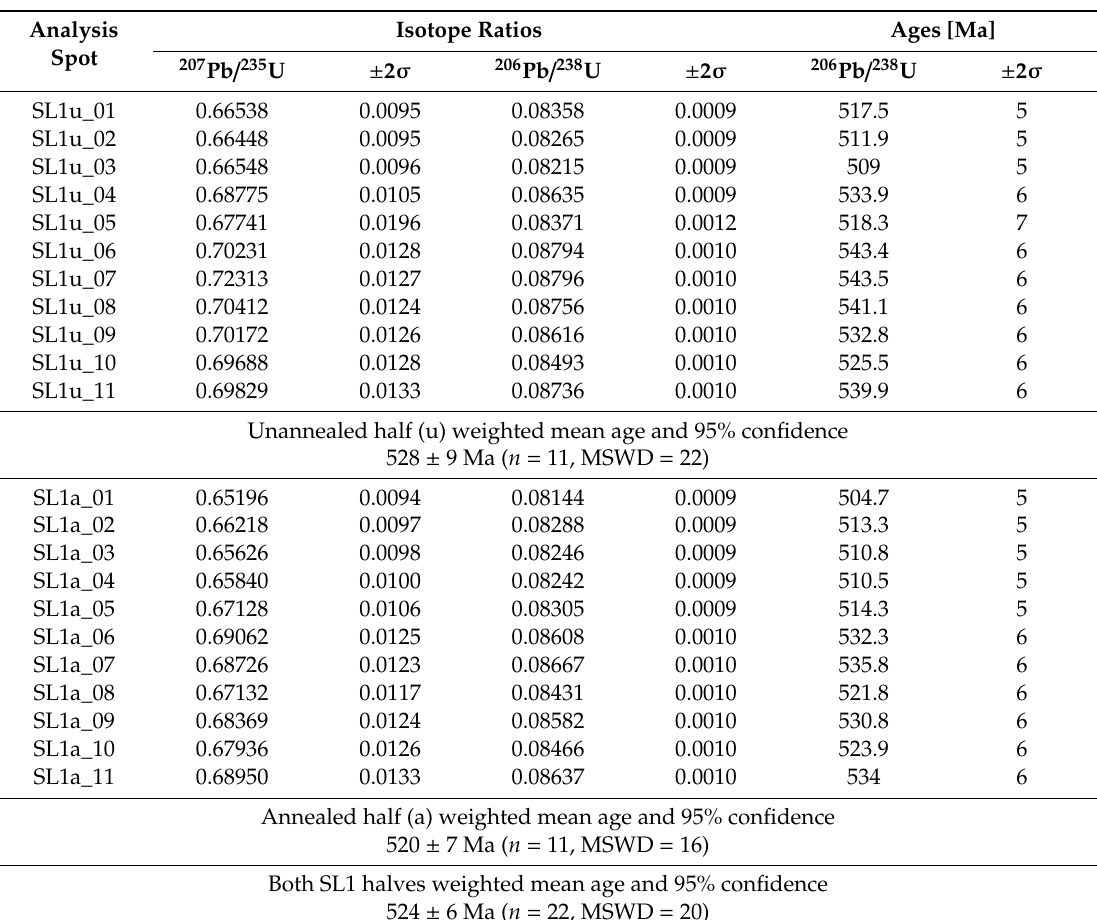
Table A3. U-Pb isotope ratios and 206 Pb / 238 U ages of the large, heterogeneous Sri Lankan zircon crystal SL1 with multiple analyses spots on both, the radiation damage-a ff ected unannealed half (u) and the heat-treated, annealed half (a) with its crystallinity